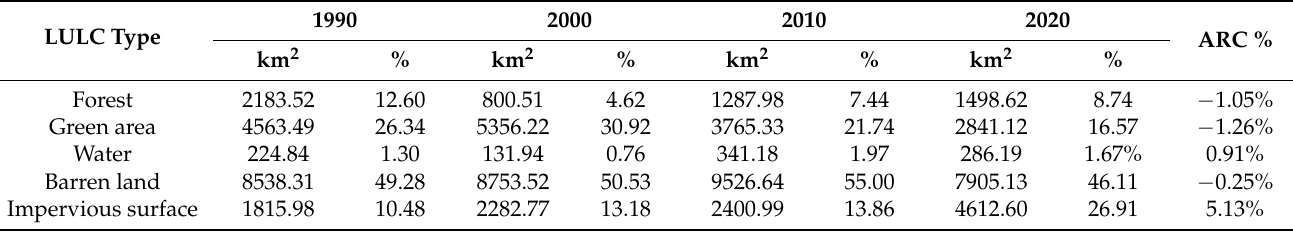
Table 3. LULC area from 1990–2020 (km 2 ) and annual rate of change